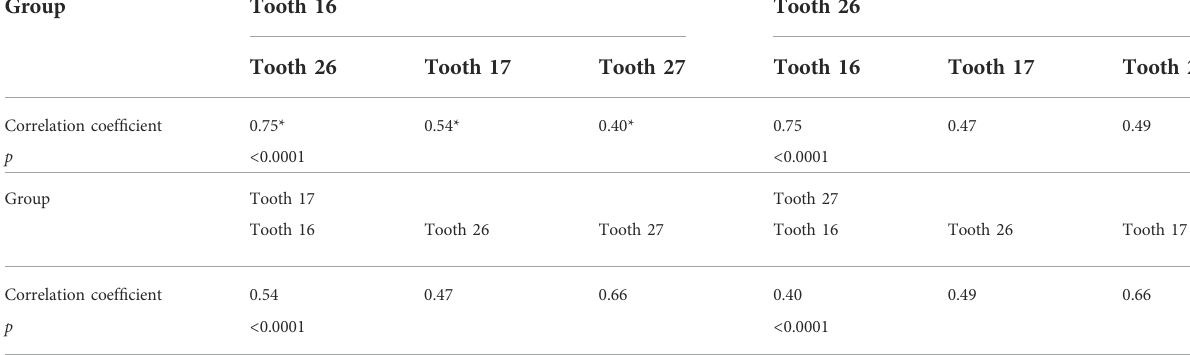
TABLE 2 Spearman ’ s correlations of MB2 incidence of different maxillary molars in Fujian area.